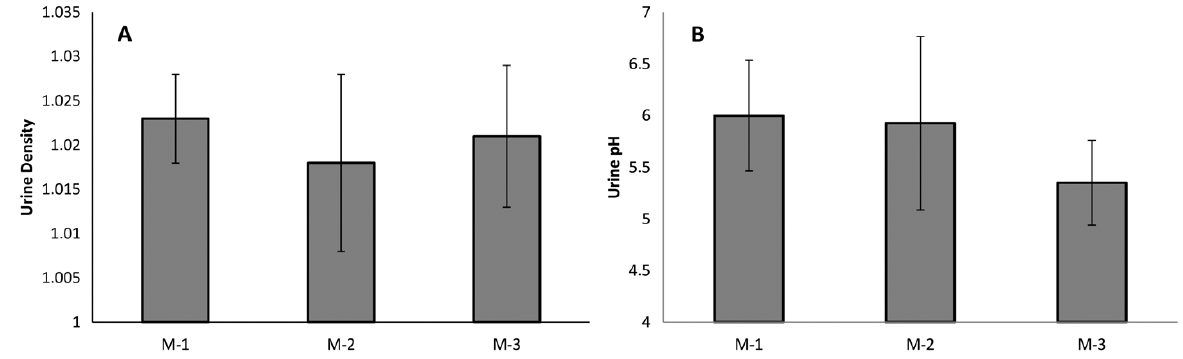
Figure 1 - Urine density (1A) and urine pH (1B) at beginning of the training season (M-1), before (M-2) and after the competition